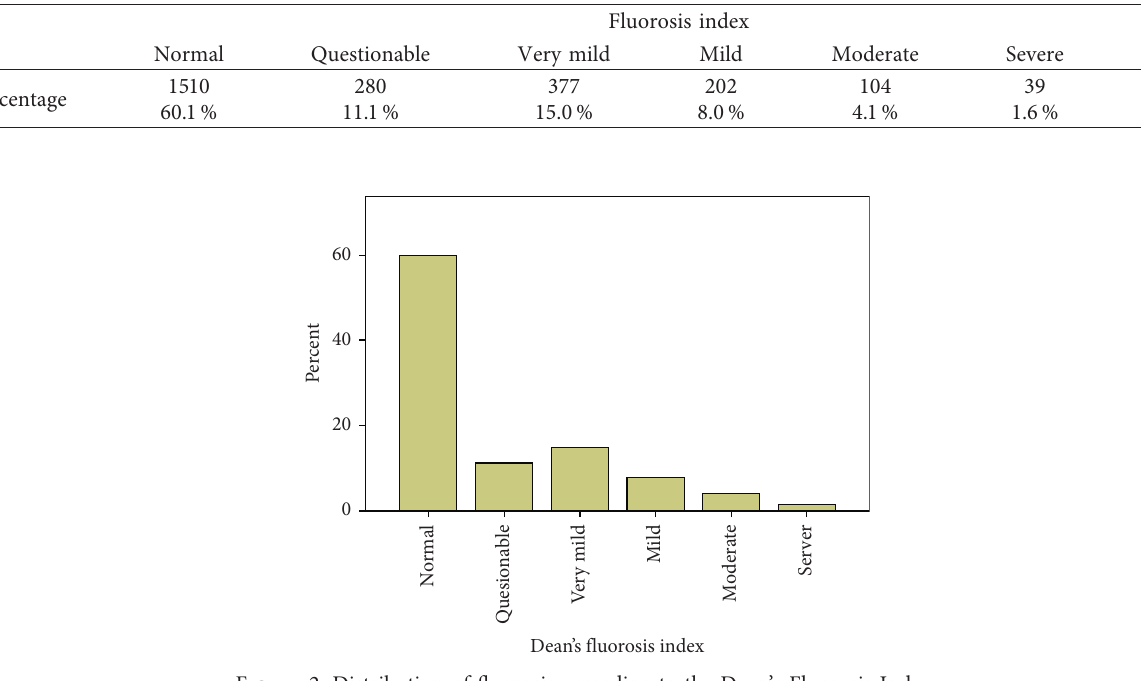
Table 3: Distribution of fluorosis according to the Dean’s Fluorosis Index.